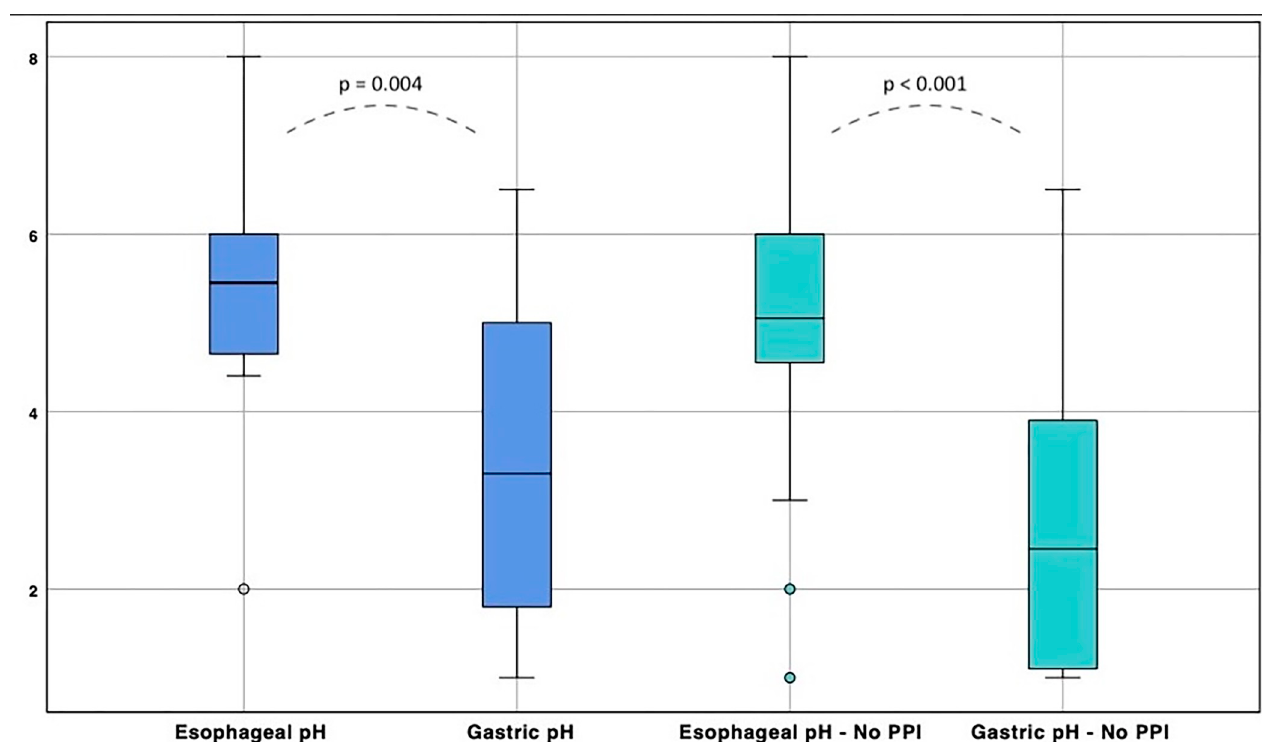
Fig 3. Measured of esophageal and gastric pH. Boxplot distribution in all patients and in patients without PPI use. Regarding the whole group analysis, a t- test score confirmed a significant difference between esophageal and gastric values (CI 99%, 0.9–2.9, p = 0.004). The subgroup analysis involving patients without PPI showed a greater difference (p < 0.001) compared to the whole group. The black bar indicates median pH, while the blue areas include the interquartile ranges for each group.